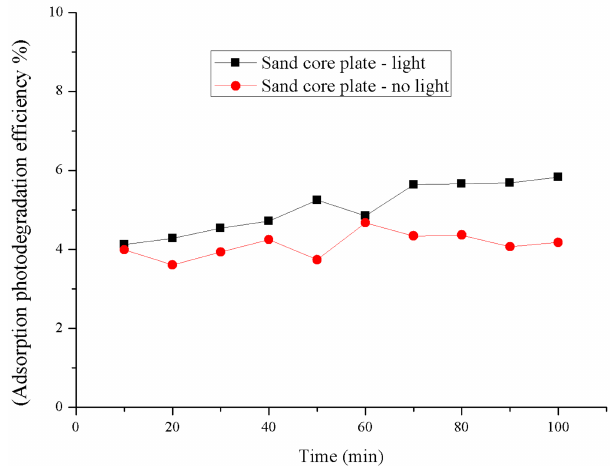
Figure 9. The comparison degradation of the blank sand core plate